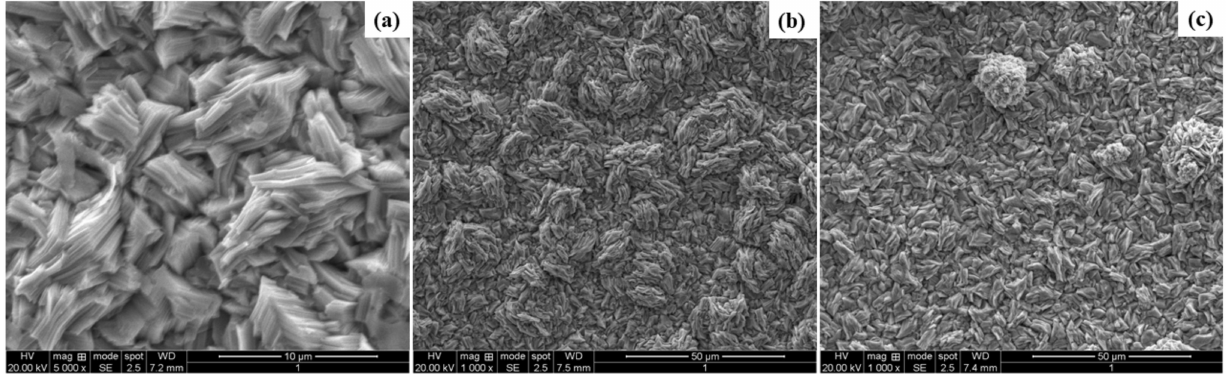
Figure 7. Surface micrographs of ( a ) Zn ( b ) Zn–WO 3 (0.5 g/L) and ( c ) Zn–WO 3 (1.0 g/L) coated